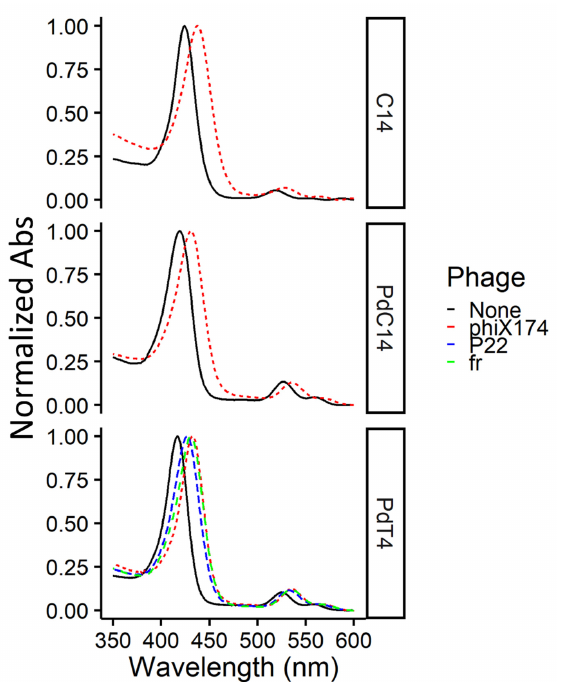
Figure 1. Normalized absorbance spectra for porphyrins C14, PdC14, and PdT4 (~2 µM) alone and with bacteriophages fr, P22, or Φ X174 (~10 10 PFU/mL) after 5-min dark incubation at room temper-